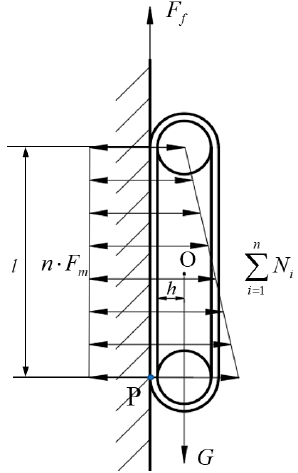
Figure 4. Static force analysis of the TWCR.